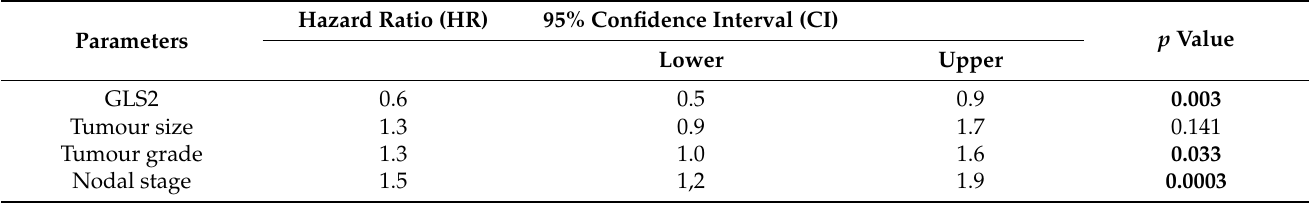
Table 6. Multivariate survival analysis of variables predicting DFI for GLS2 protein expression in ER +/HER2- invasive breast